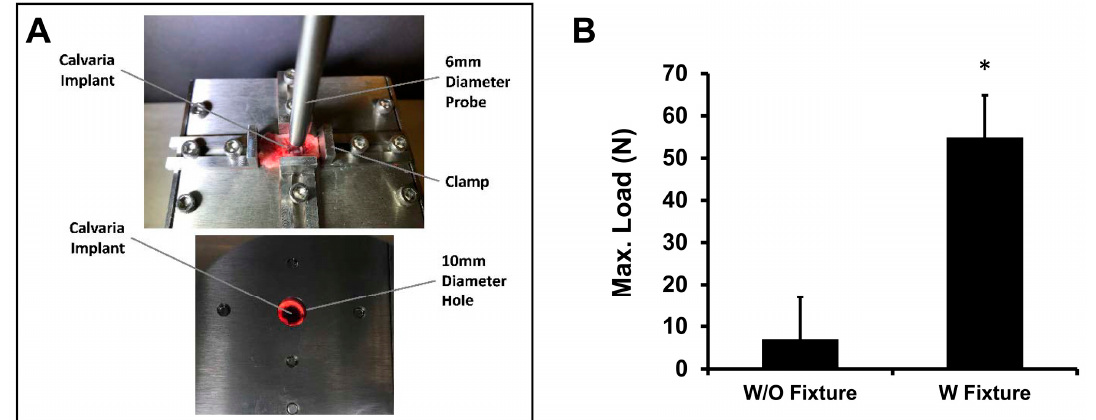
Figure 3. ( A ) Apparatus of push-out test, ( B ) mechanical strengths of scaffold after 12 weeks of implantation with and without Gelfoam ® and Ti mesh. A rat calvarial explant was placed on the apparatus and fixed by pairs of clamps as increasing amount of load was applied on the scaffold.